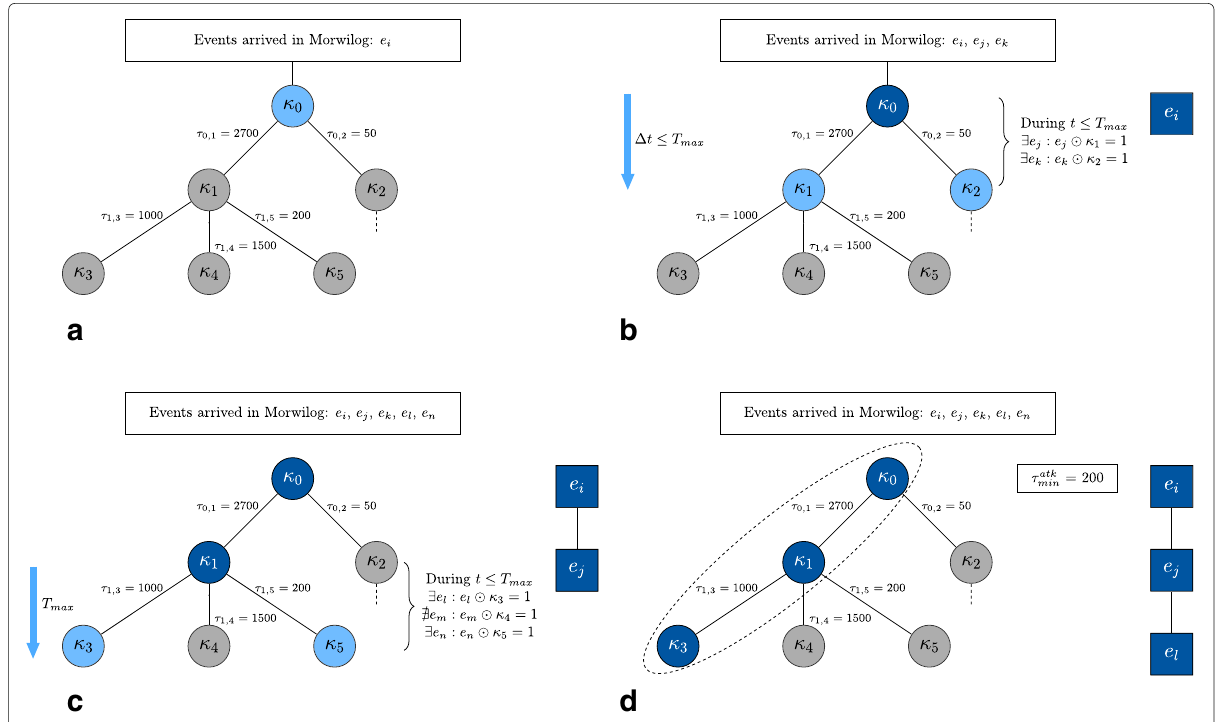
Fig. 7 Example about the progress of a morwi through an event tree with parameters in Table 2. a e i arrives, morwi chooses tree δ j with e i (cid:6) κ 0 = 1, b morwi has to choose between found events in level 2, c Pheromone-based weighted random selection, d attack if τ 1,3 > τ atk